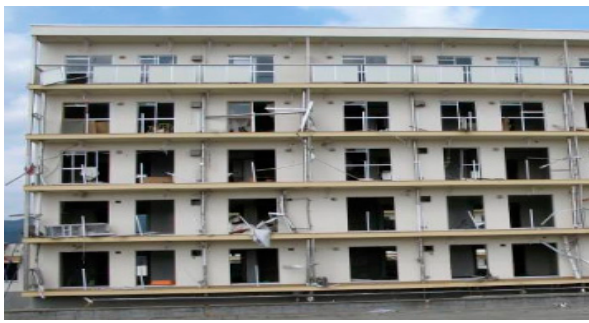
Figure 22. Reinforced concrete building, inundation depth 10 m, Rikuzentakata City.